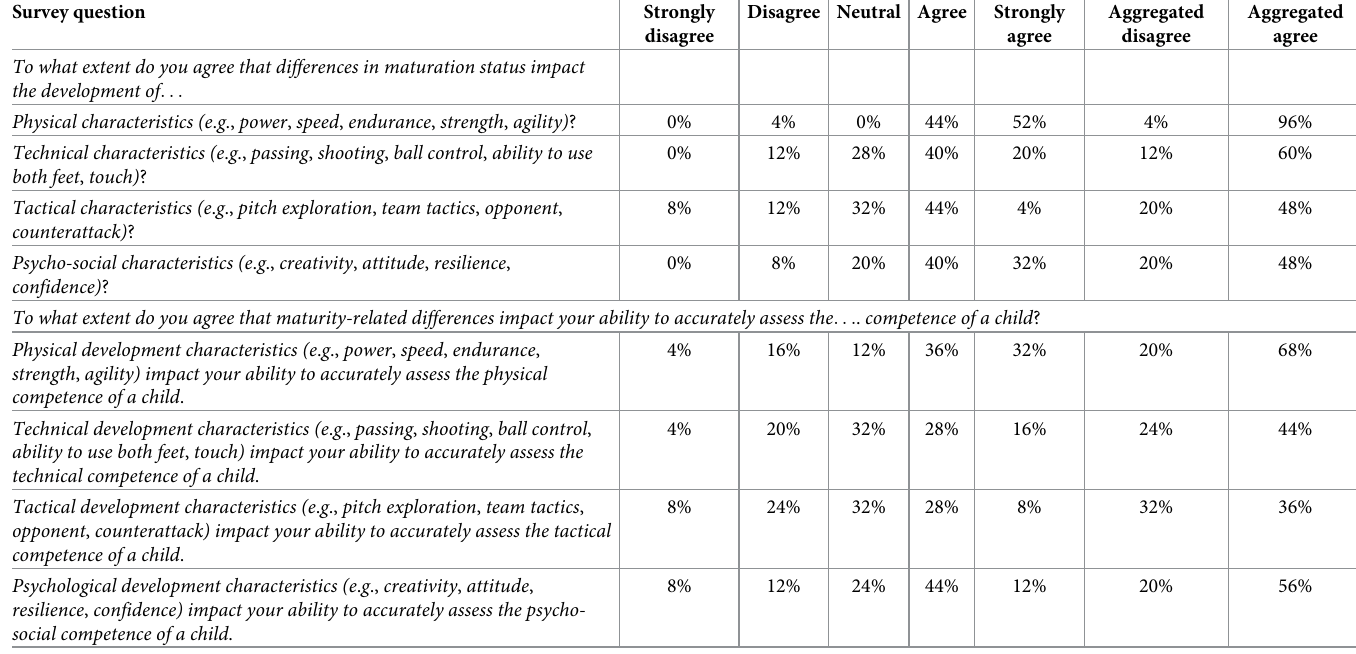
Table 1. Summary table of practitioner individual and aggregated (i.e., Sum of strongly disagree and disagree; sum of strongly agree and agree) perceived agree- ment that differences in maturation can impact the development of and their assessment of physical, technical, tactical, and psycho-social characteristics of acad- emy soccer players. Survey